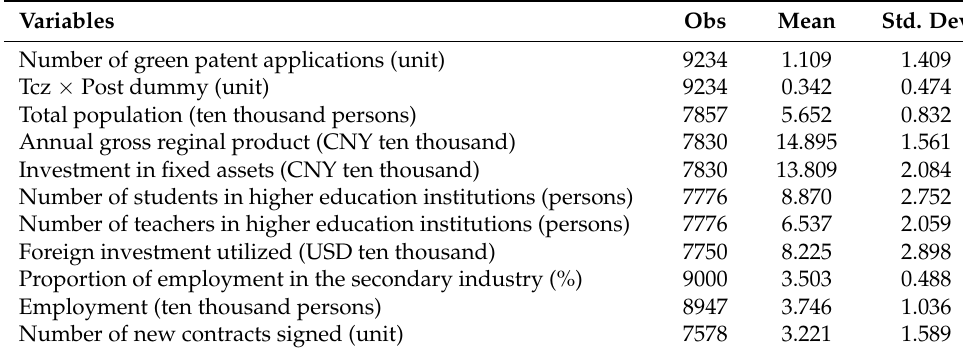
Table 1. Summary